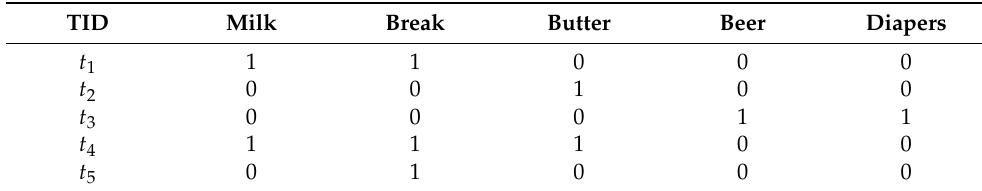
Table 1. Transaction set in a supermarket. Milk